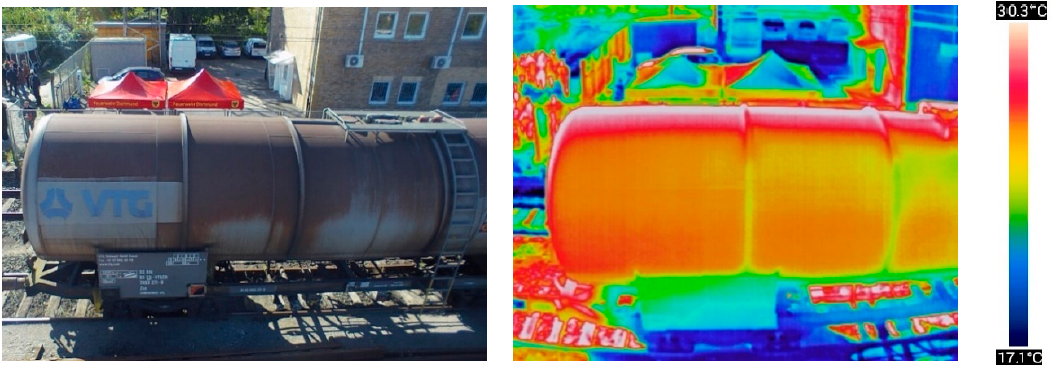
Figure 2. Comparison of images from RGB and thermal imaging cameras—a railway wagon tank (21.09.2019 Radoslaw Fellner).